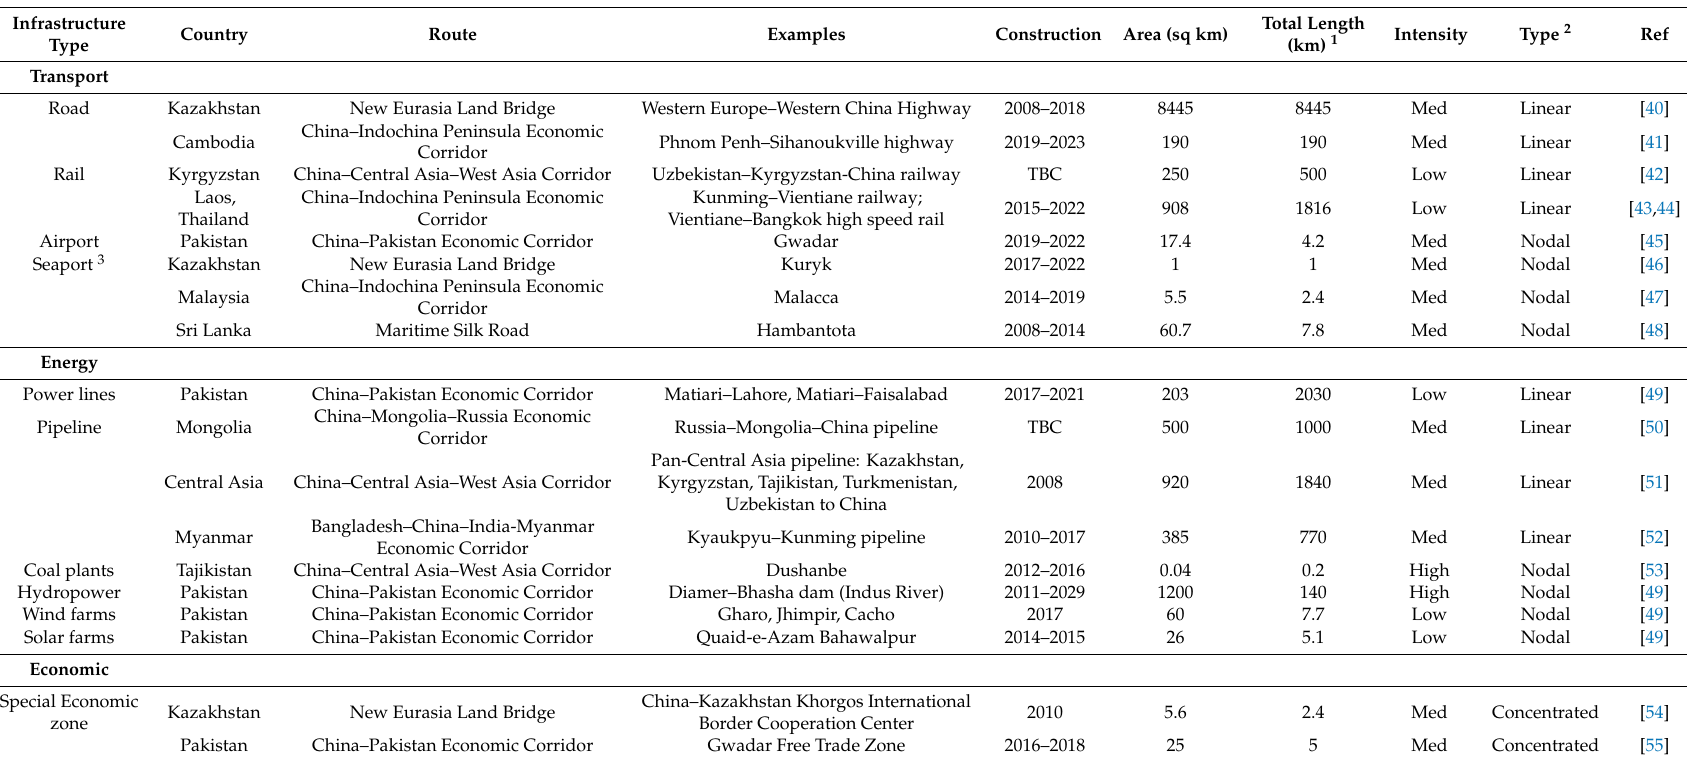
Table 1. Examples and characteristics of infrastructure built for Belt and Road Initiative (BRI) for a range of BRI